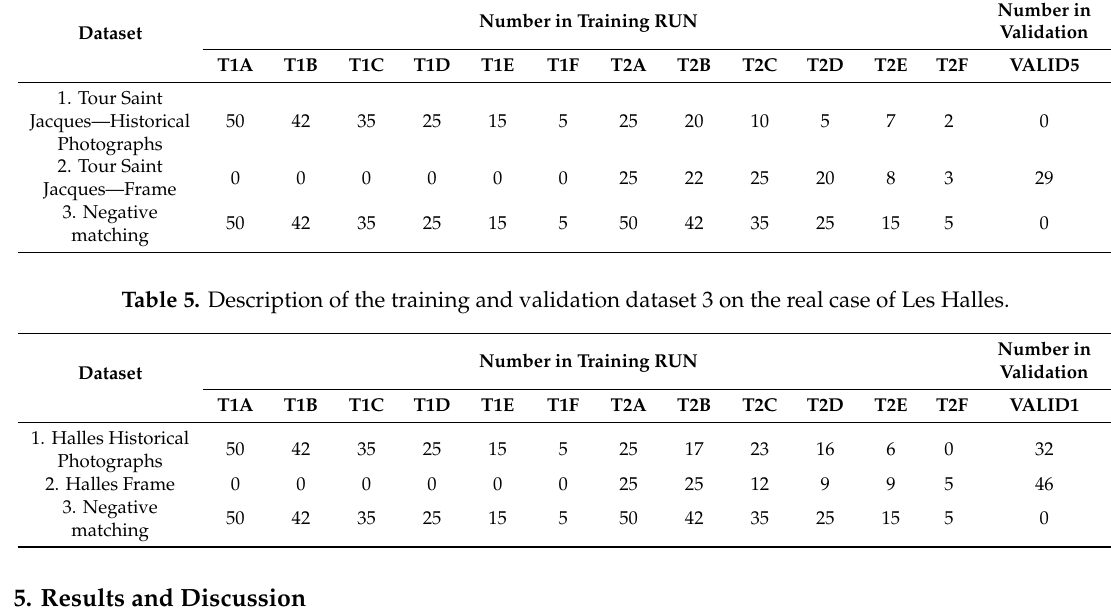
Figure 9. Specificity trend of RUN A with valid 2 and 3. The difference between the specificity results of valid2 and valid3 sets is not surprising. Since the training runs start from pre-trained networks, it is expected that common categories are already stored—in the neural network sense—in the initial weights of the network. Indeed, from the validation results represented in Figure 9, it can be ascertained that only a few false positives correspond to landscapes whereas a significant amount of shapes similar to the tower are misinterpreted by the network as the Tour-Saint Jacques tower. In this scenario, to address the most frequent false positive type, the valid3 image set, containing shapes similar to the searched Tour Saint Jacques, was used as a negative matching set in the subsequent runs.